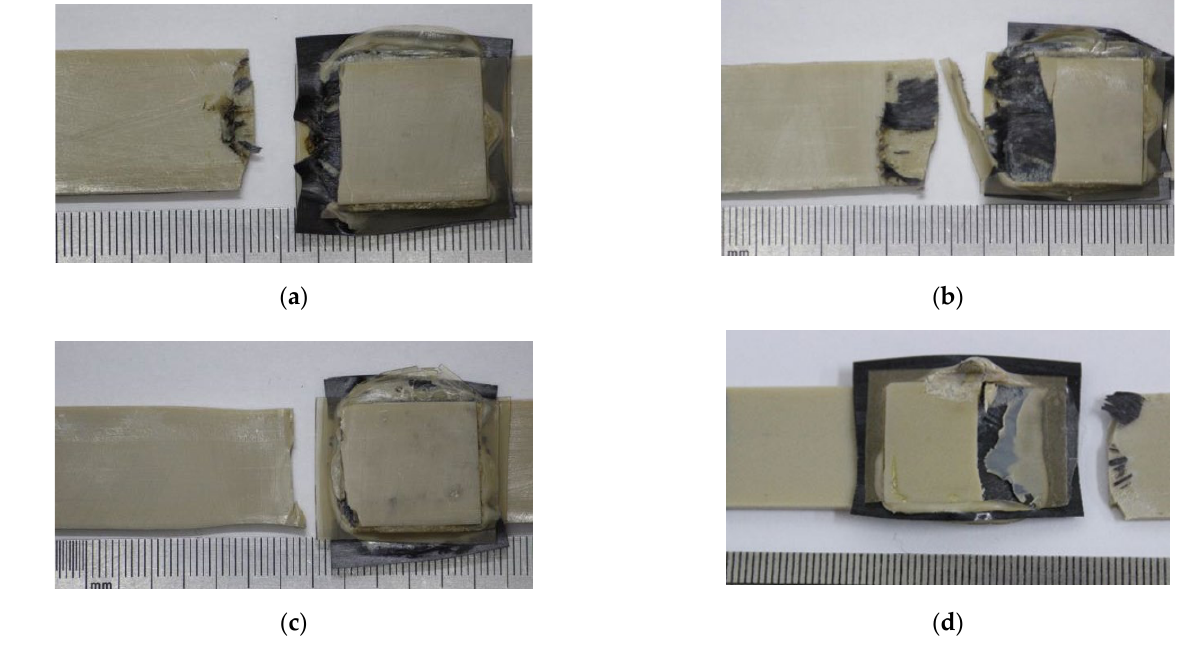
Figure 9. Fracture patterns of lap joints. Mode #1 ( a ); mode #4 ( b ); mode #9 ( c ); mode #10 ( d ).